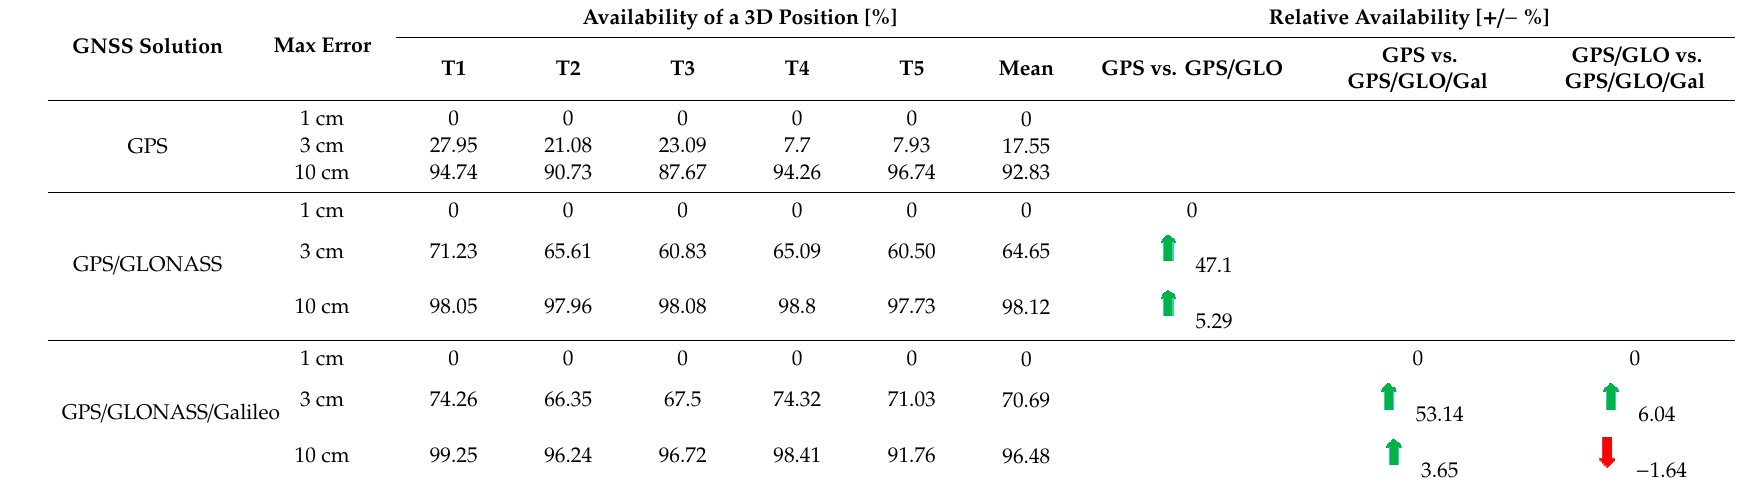
Table 3. The mean and minimum Position Dilution of Precision (PDOP) and the Number of Satellites (NoS) used by the five GNSS geodetic receivers (T1–T5) in measurements during the journeys, with the use of RTK corrections from Global Positioning System (GPS) and GPS/Global Navigation Satellite System (GLONASS) satellites.